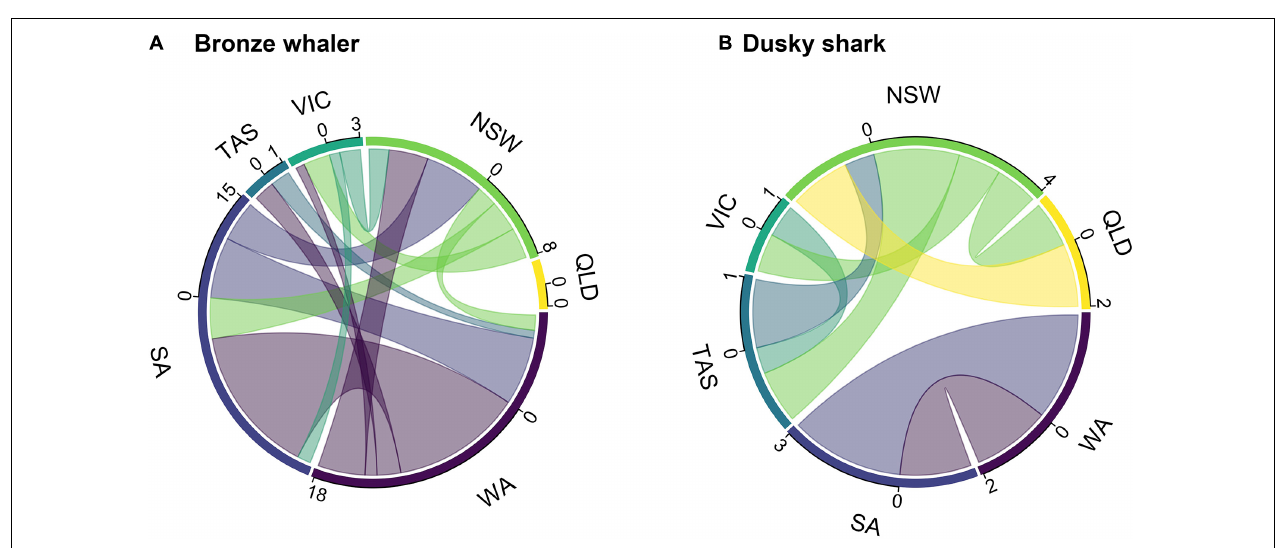
Tracking days represent period between date of tagging and last detection.